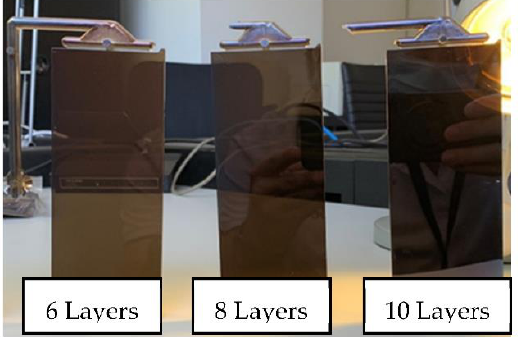
Figure 12. Sequential staining image of six to 10 layers to chromium.